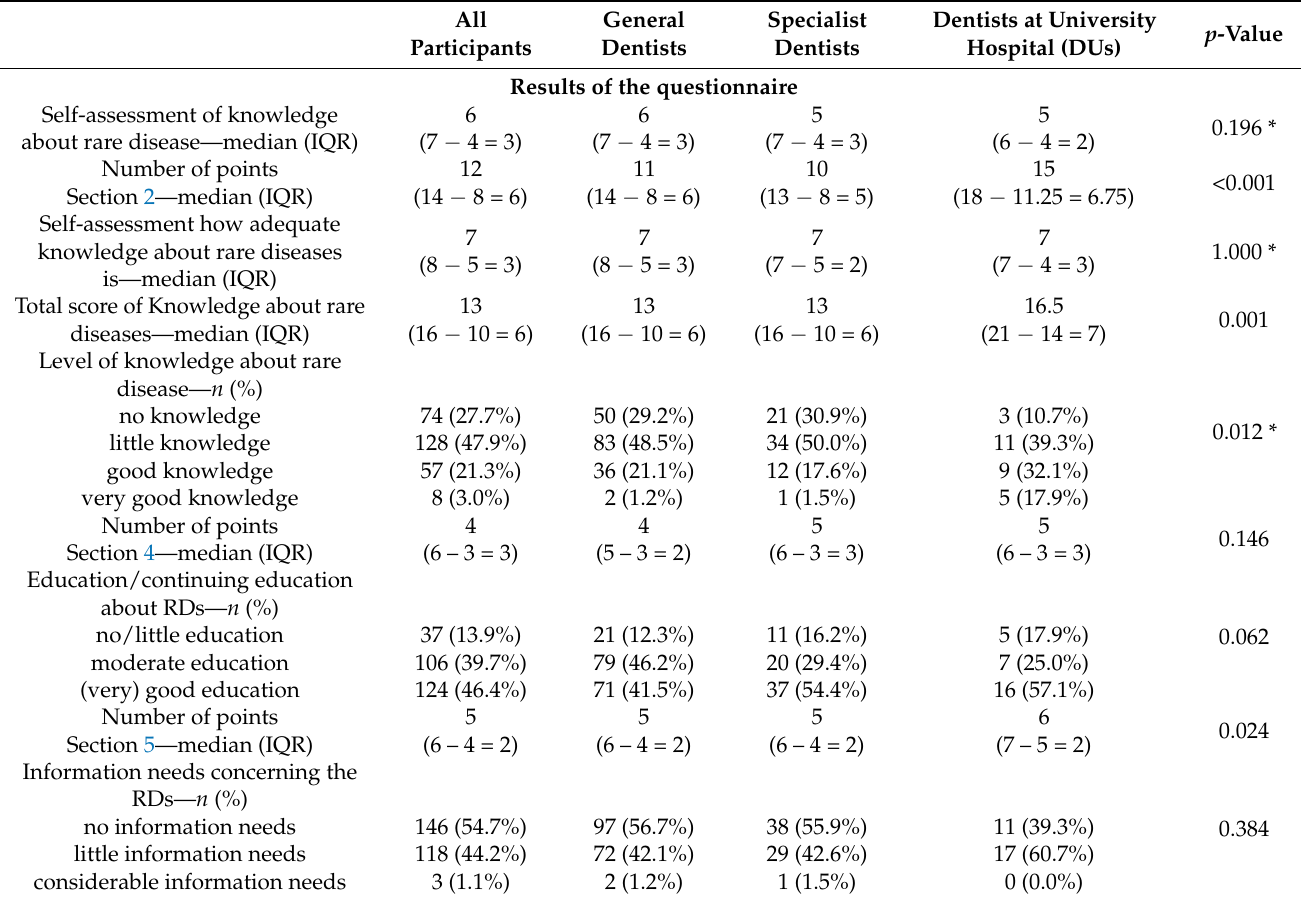
Table 2. Results of Sections 2–5 2 of the questionnaire. IQR = interquartile